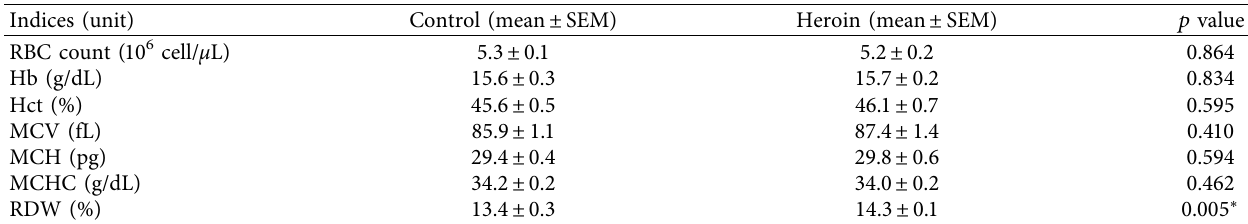
Table 1: Comparison of red cell indices among chronic heroin addicts and control subjects: there was no significant difference between control and heroin-addicted subjects, in all red cell indices, except the RDW ( p < 0 . 05). Indices (unit)